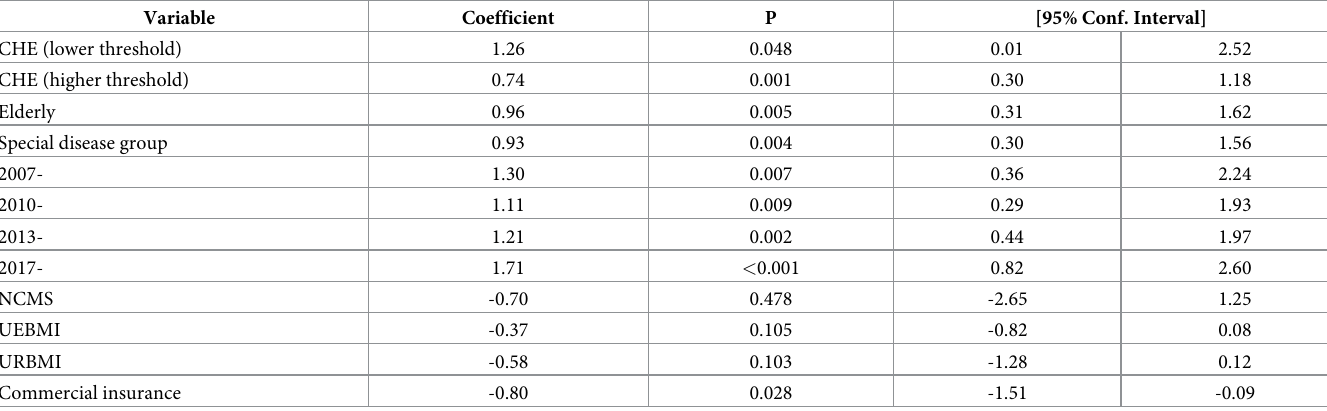
Table 2. Meta-regression of factors associated with rate of catastrophic health